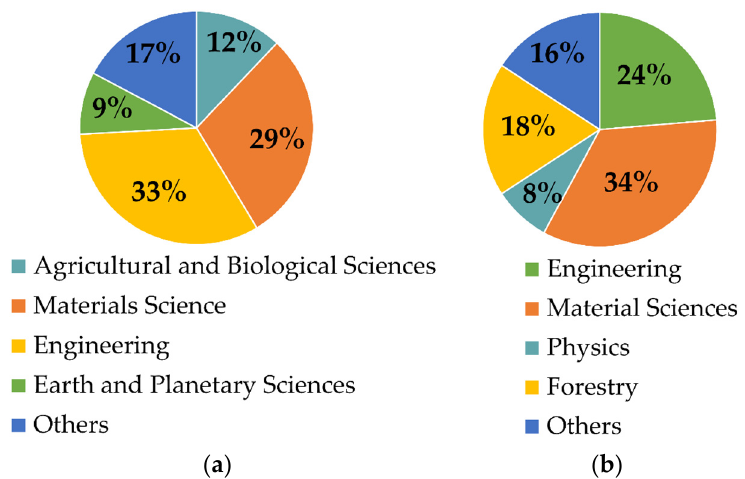
Figure 5. ( a ) Percentage of subject areas of expertise of the authors representing their research field and cultural background; ( b ) Percentage of the main subject areas of the journals.